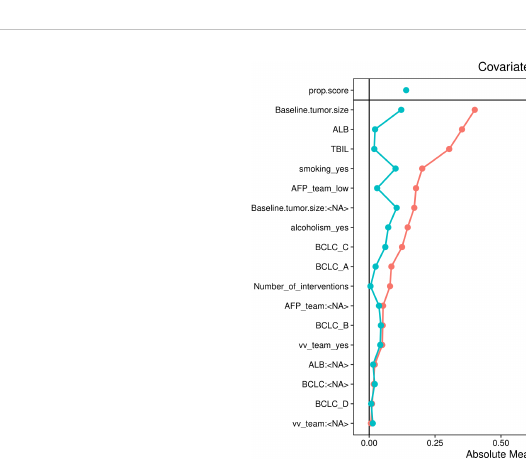
FIGURE 6 Love plot for standardised baseline differences before and after IPTW.